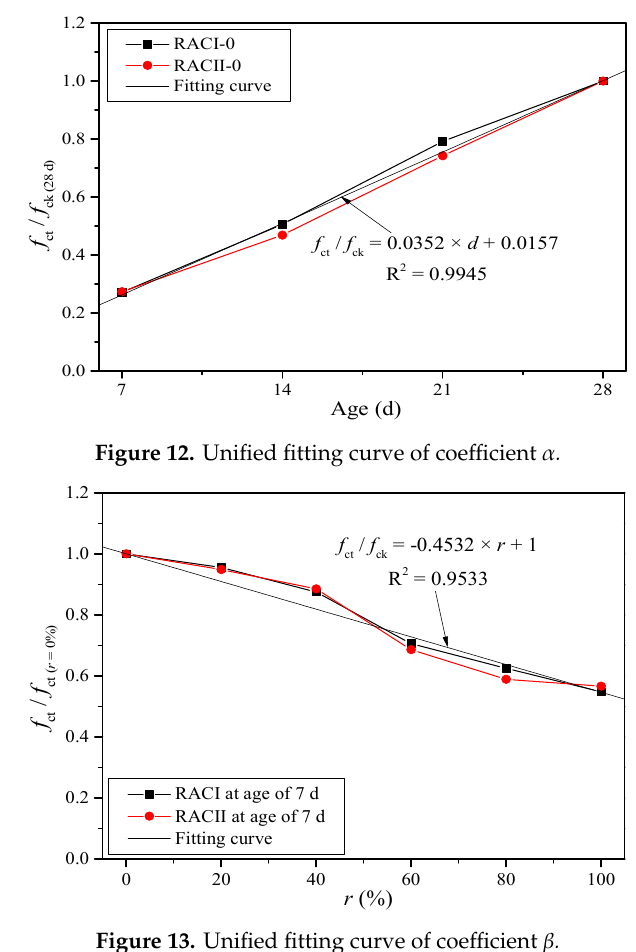
Figure 13. Unified fitting curve of coefficient β.